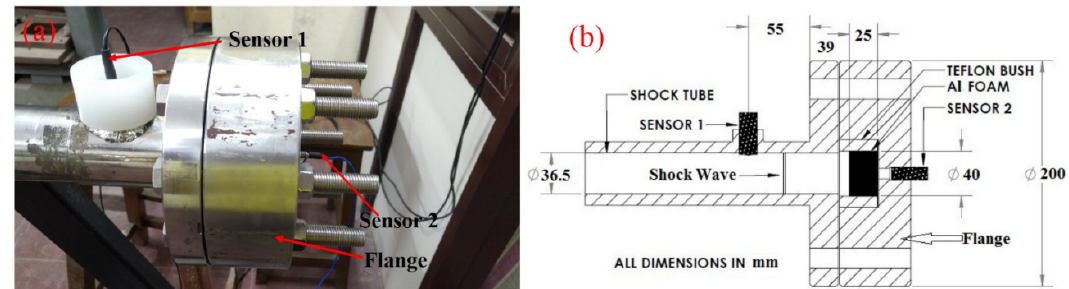
Figure 1. ( a ) Stainless steel flange of the shock tube for mounting foam samples. ( b ) Details of foam and sensor placement inside the flange.